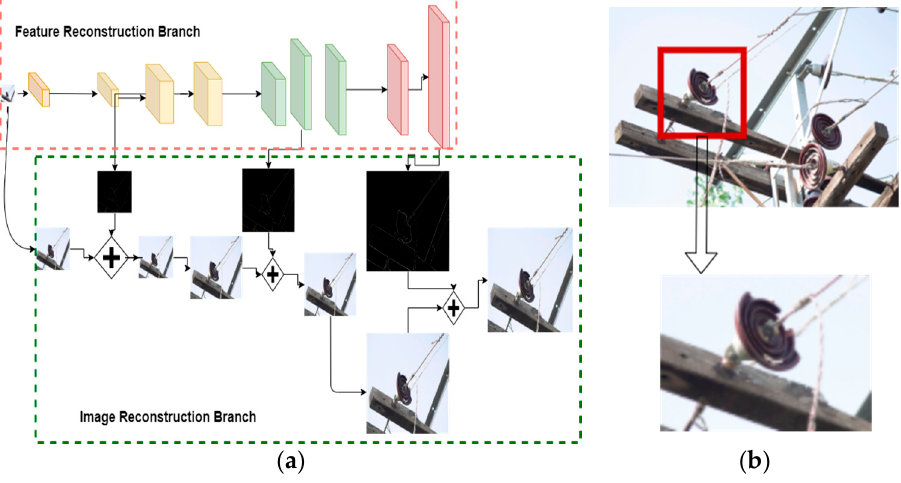
Figure 10. ( a ) Workflow of LapSRN for upsampling a low-resolution image, ( b ) LR patch extrac-